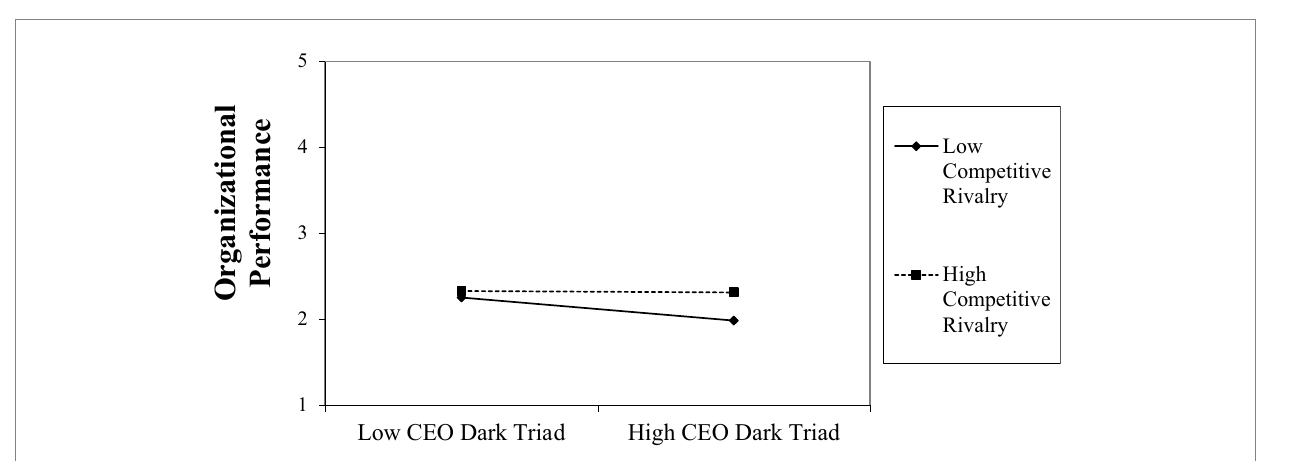
FIGURE 4 Interaction effects of competitive rivalry on CEO dark triad in terms of organizational performance.